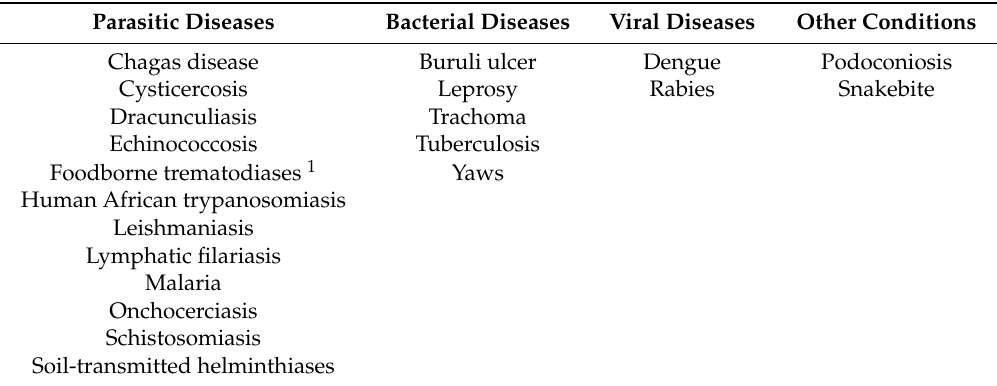
Table 1. WIPO Re:Search fosters drug, vaccine, and diagnostic R&D for 21 diseases of poverty through IP sharing and targeted